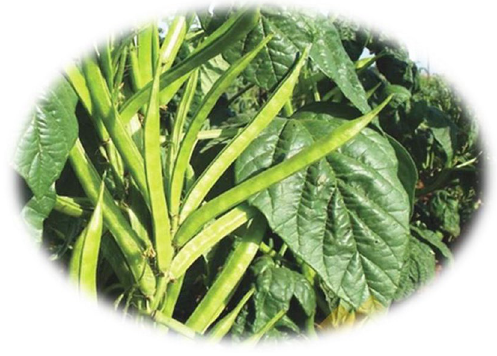
Fig. 10 Seeds of Cyamopsis tetragonoloba as a coagulant